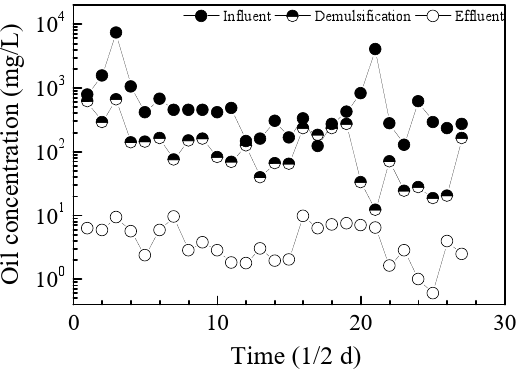
Figure 6. Oil removal performance of the pilot plant in the Xinjiang Oilfield. CP-1 dose, 350 mg/L. PAC dose, 500 mg/L. Temperature, 14~22 °C.